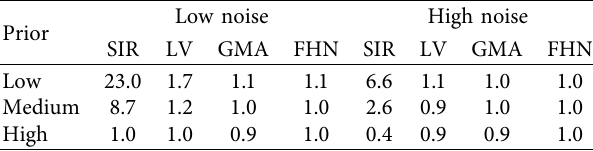
Table 3: MSE ratios for nonlinear parameters (small samples).